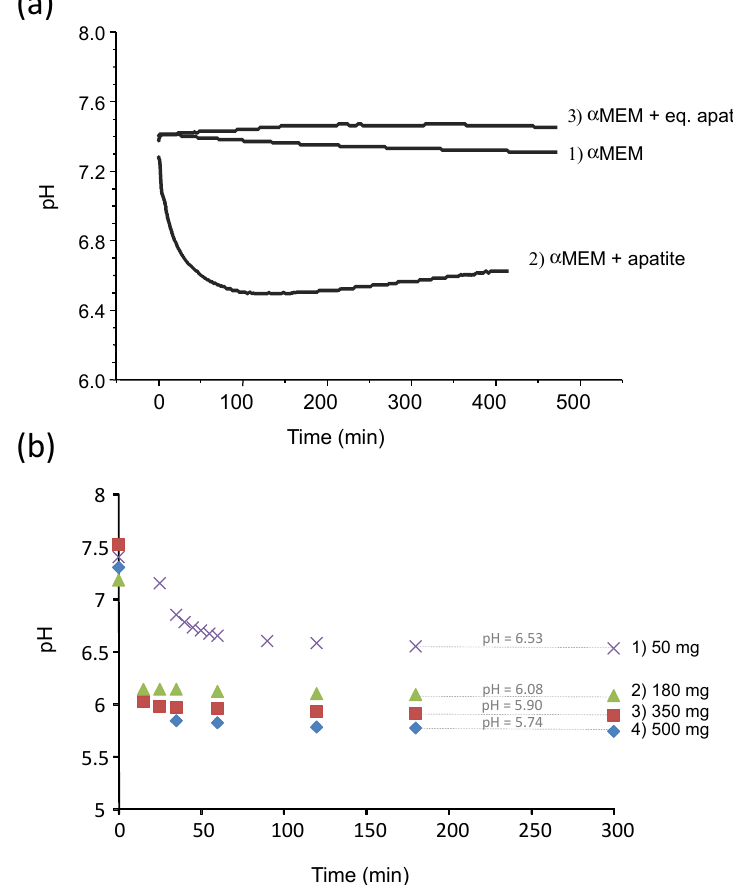
Figure 2. ( a ) pH evolution over time at 37 °C of α MEM medium, with or without re-immersed hap-1d apatite compound. The terms “eq. apatite” refer to sample hap-1d equilibrated at pH 11 in Na 3 PO 4 · 12H 2 O during the washing step (see text); ( b ) pH evolution over time in deionized water (20 mL, initial pH 7.4) upon re-immersion of an increasing mass of hap-1d apatite compound.